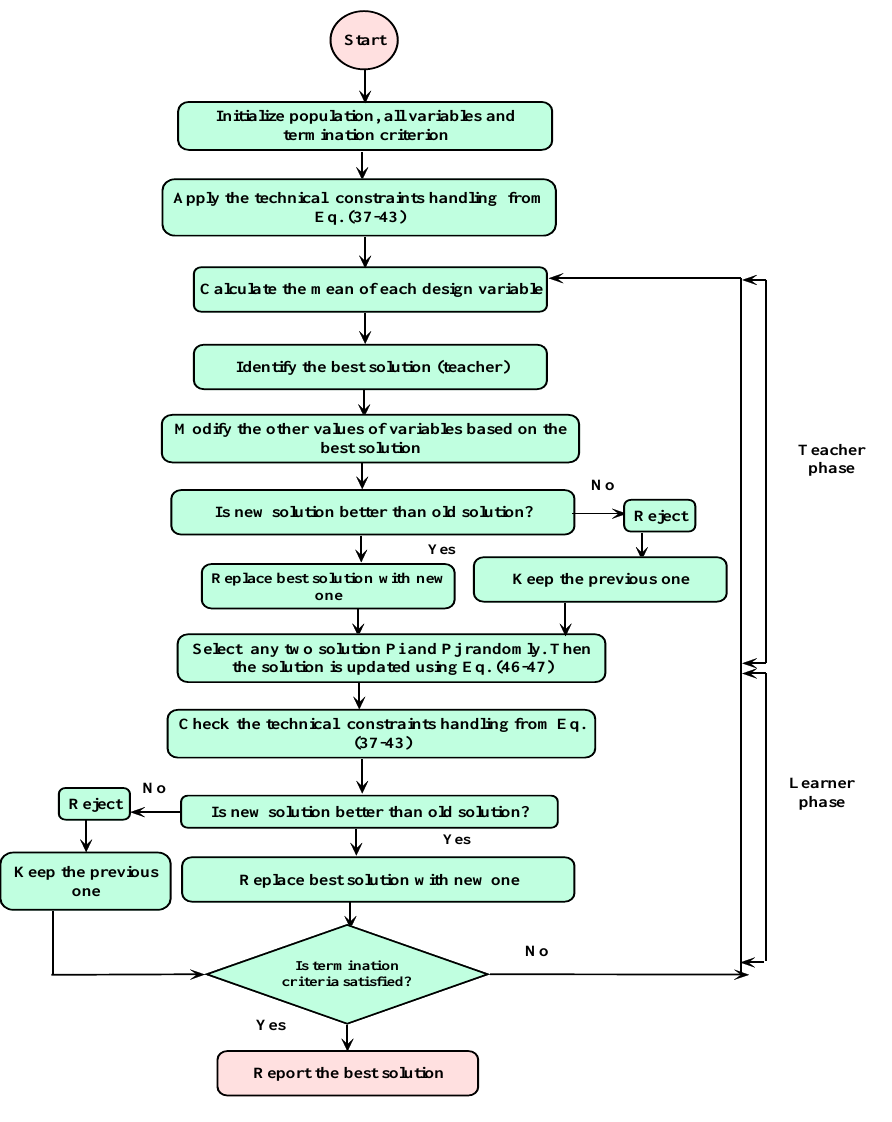
Figure 3. Flowchart of modified TLBO. Table 3. Comparison of modified TLBO algorithm with other optimization methods. Reference